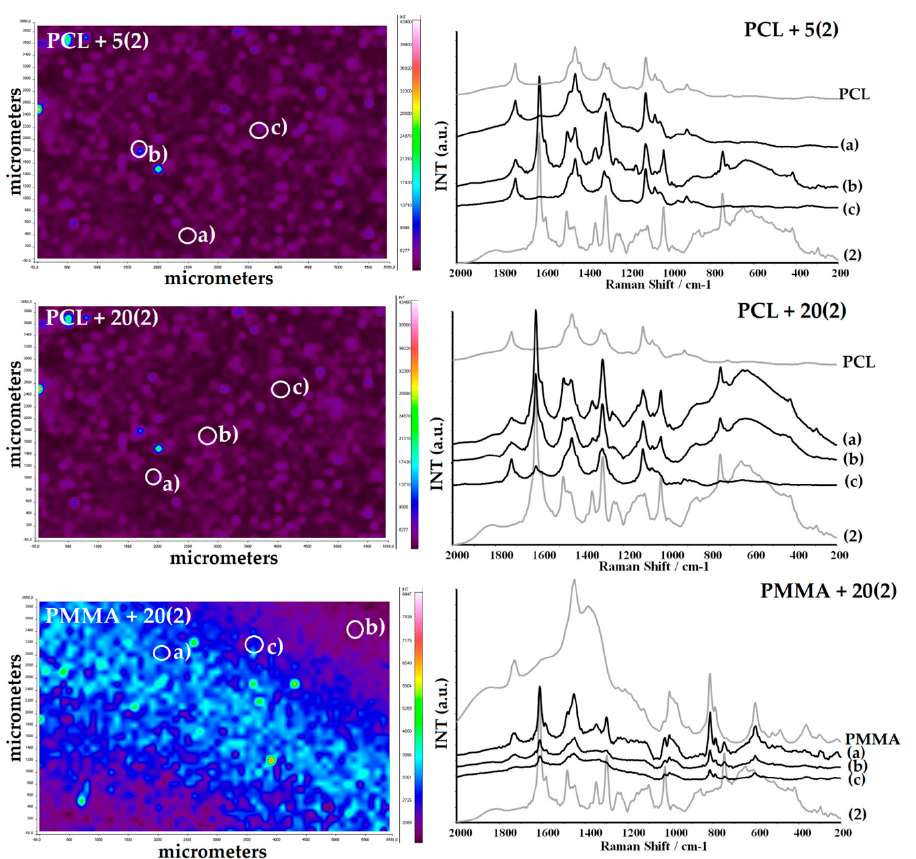
Figure 3. Raman microscopy maps and spectra of PCL + 5( 2 ), PCL + 20( 2 ), and PMMA + 20( 2 ) com- Figure 3. RamanmicroscopymapsandspectraofPCL+5( 2 ), PCL+20( 2 ), andPMMA+20( 2 )composites. posites.